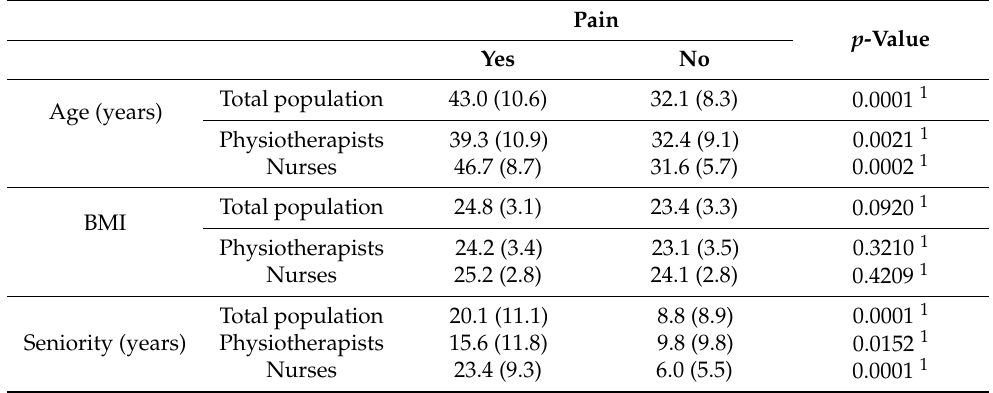
Table 6. Results.